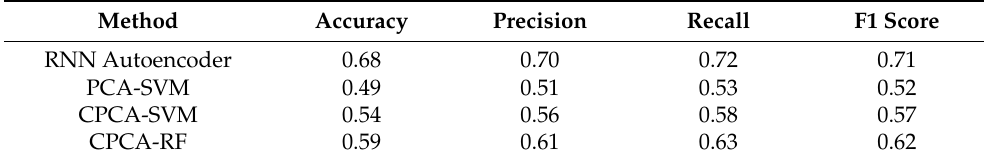
Table 6. Comparison results of models based on SVM classification